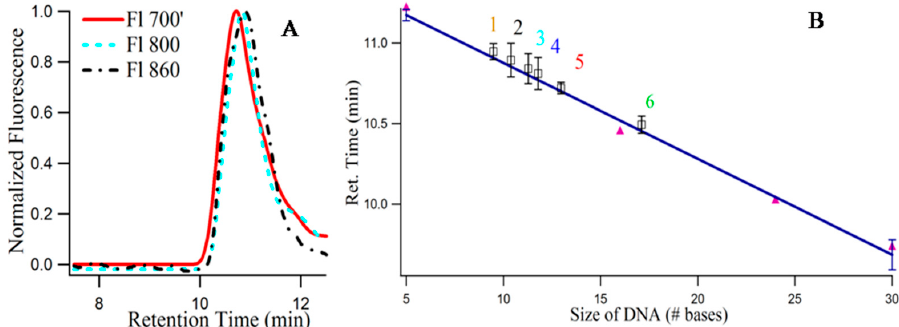
Figure 8. ( A ) Size exclusion chromatogram of the three fluorescent Ag nanocluster species of template 3T4G: Red (solid), cyan (- - -), and black (-.-.-) lines correspond to λ ex = 620/ λ em = 700 nm (I), ( λ ex = 730/ λ em = 800 nm (II) and λ ex = 830/ λ em = 860 nm (III); ( B ) Calibration curve using the single-stranded thymine oligonucleotides dT 5 , dT 16 , dT 24 , and dT 30 (purple solid circles) as the size standards to relate the column retention times to the log of molecular mass of the silver nanoclusters of 1. MB3T4G ( λ ex = 540/ λ em = 620 nm); 2, 3, and 5 correspond to Species III, Species II, Species I of 3T4G in buffer; 6. Species I of 3T4G in methyl-beta-cyclodextrin; 4 denotes the retention time of the 3T4G free DNA (using absorbance value at 260 nm). Each data point is average of three independent measurements and the bars indicate the standard